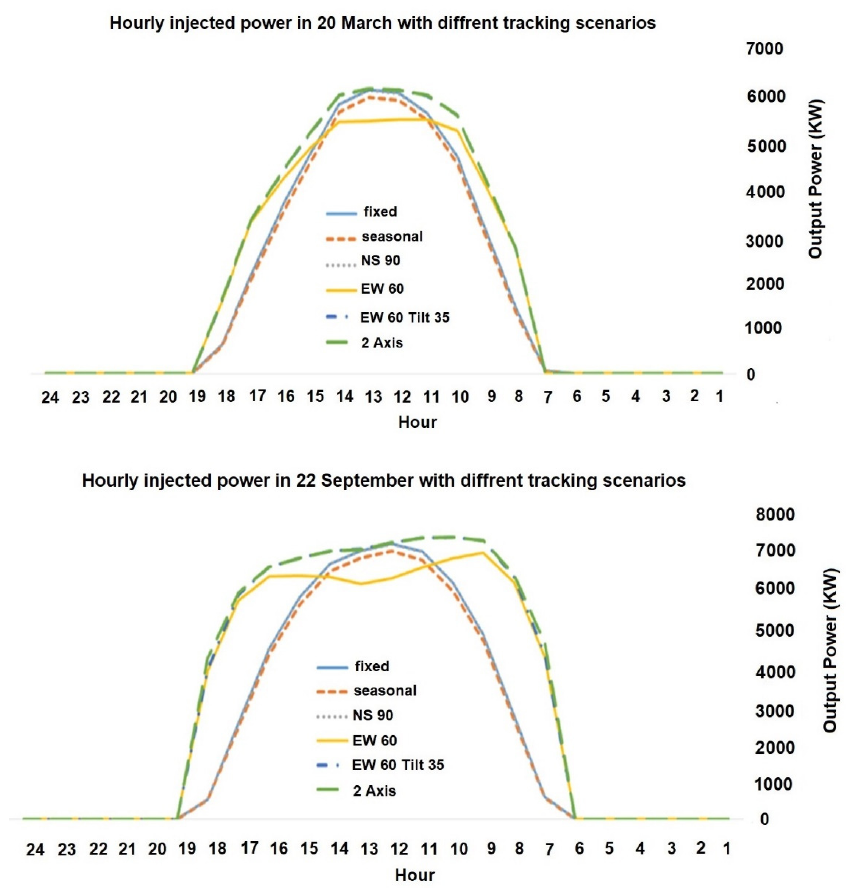
Figure 17. Comparing the daily performance of the hypothetical 10 MW power plant in Qom on different dates under the different tracking scenarios. different dates under the different tracking